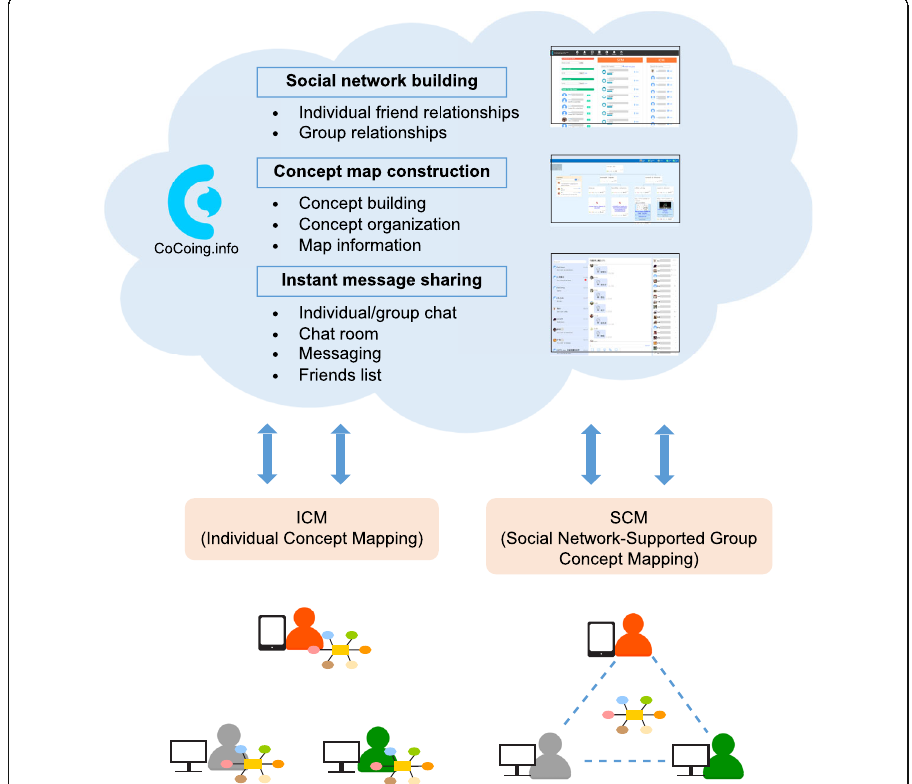
Fig. 1 ICM and SCM scenarios on